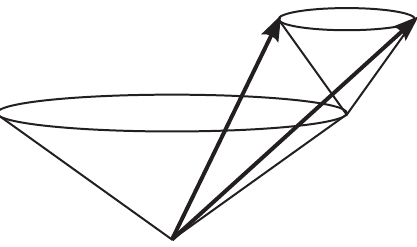
FIG. 5. A graphical representation of the inherent uncertainty in quantum angular momentum. The large cone represents L , the small cone S , and the two arrows represent two possible (classical) angular momentum vectors with different magnitudes. The cones here are arbitrary (they do not match the state given in the